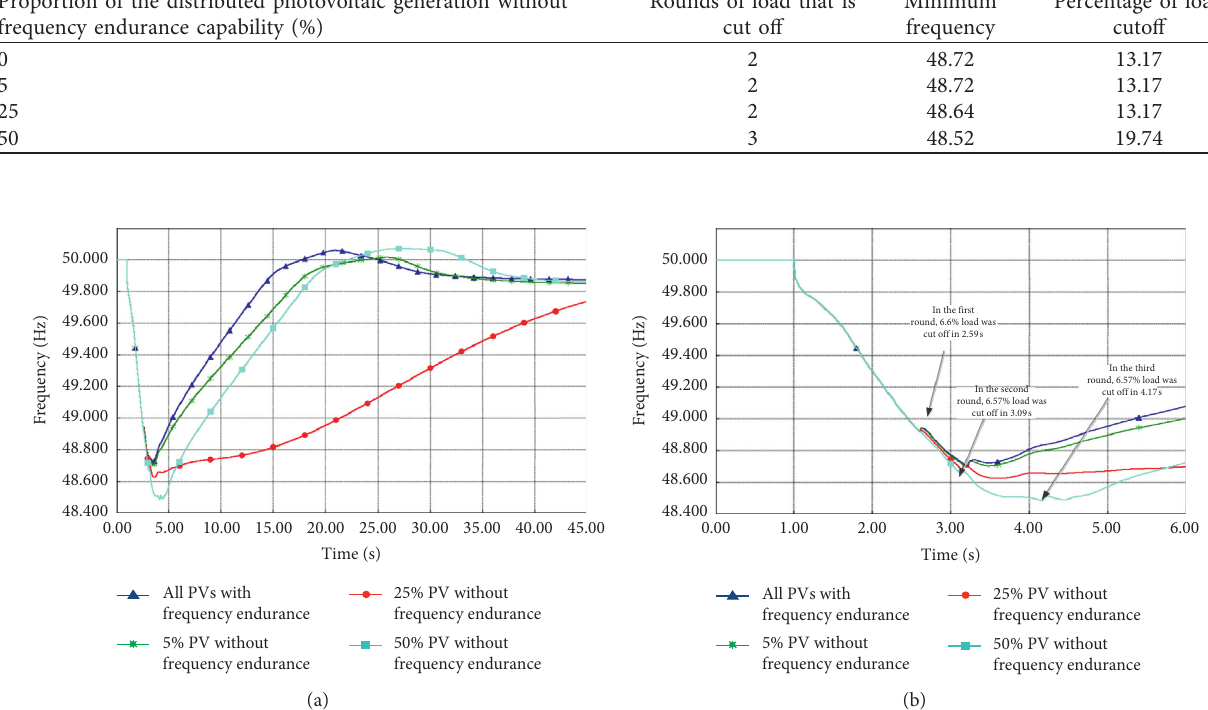
Table 5: Low-frequency load shedding scheme of Hunan power grid. Proportion of the distributed photovoltaic generation without frequency endurance capability